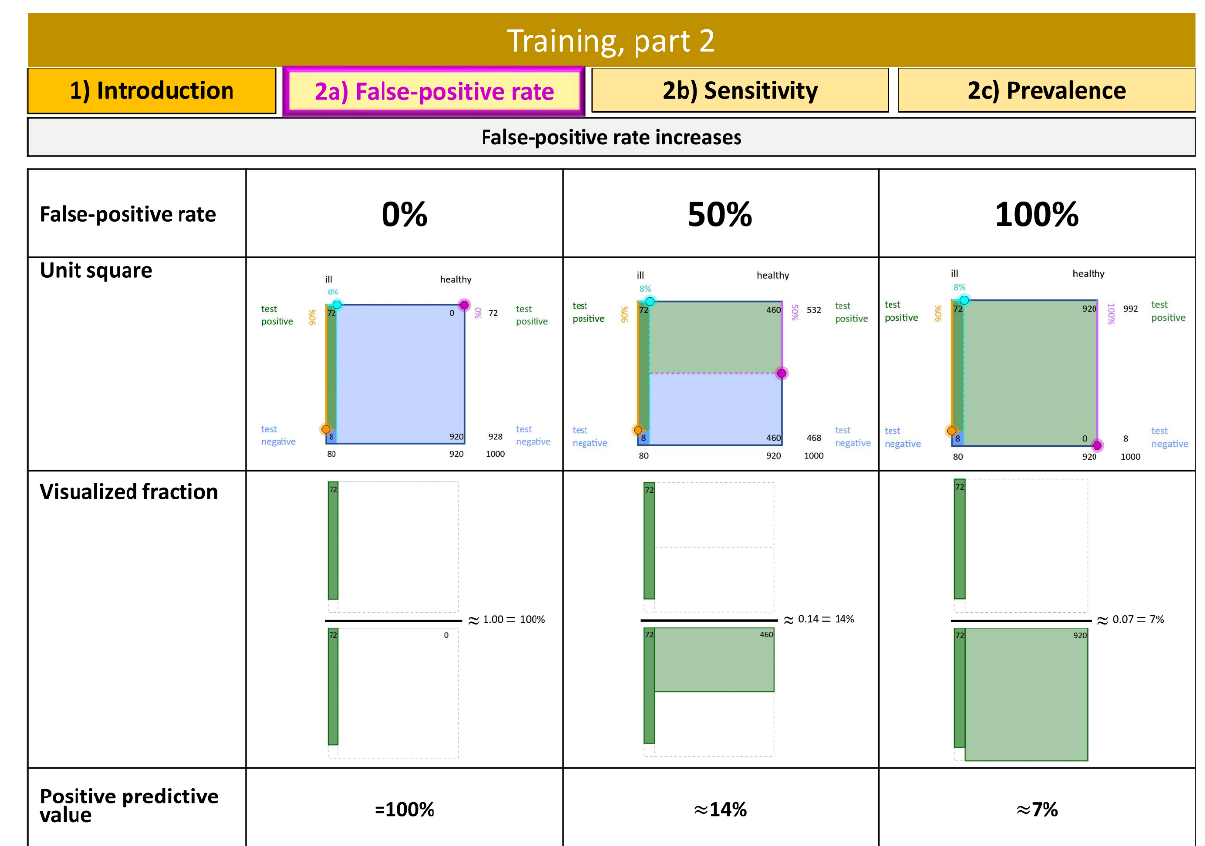
Figure 10. Screenshot of the explanatory video on changes in the false-positive rate including a table of the visualization (here: unit square) with the visualized fraction for the values of 0%, 50% and 100% of the false-positive rate. This is available in the legend while working on the task of covaria- tion.